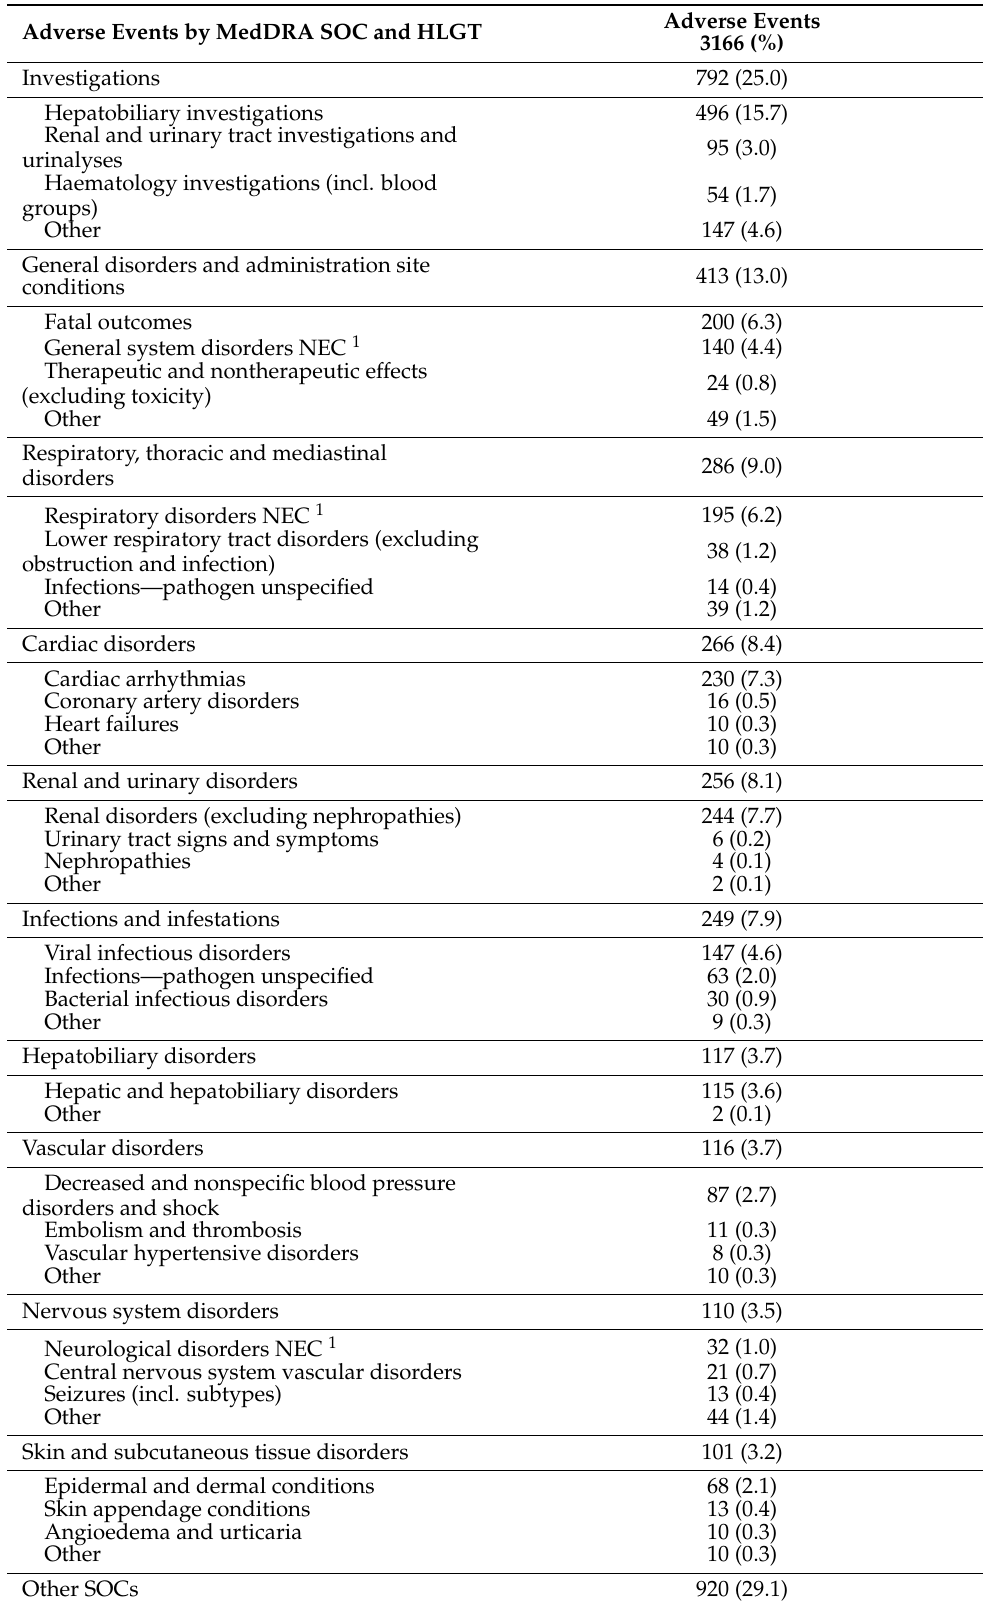
Table 3. Top 10 distribution of adverse events by MedDRA System Organ Class, and top three High-Level Group Terms (HLGT) within each System Organ Class